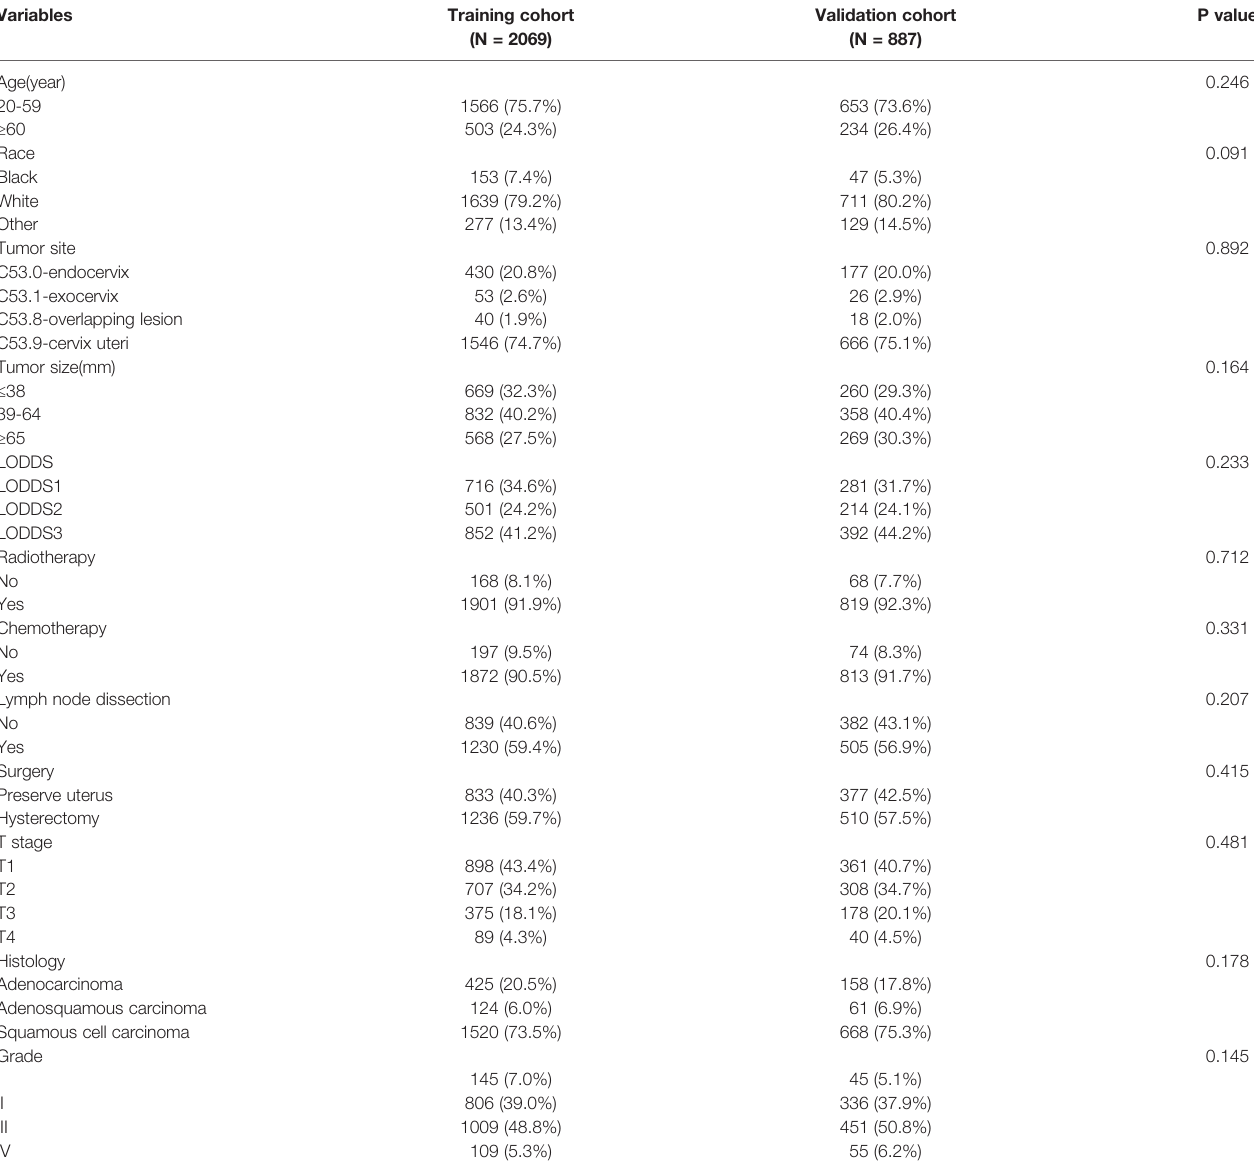
TABLE 1 | Baseline clinicopathological features of cervical cancer patients with lymph node metastasis in the training cohort and the validation cohort.